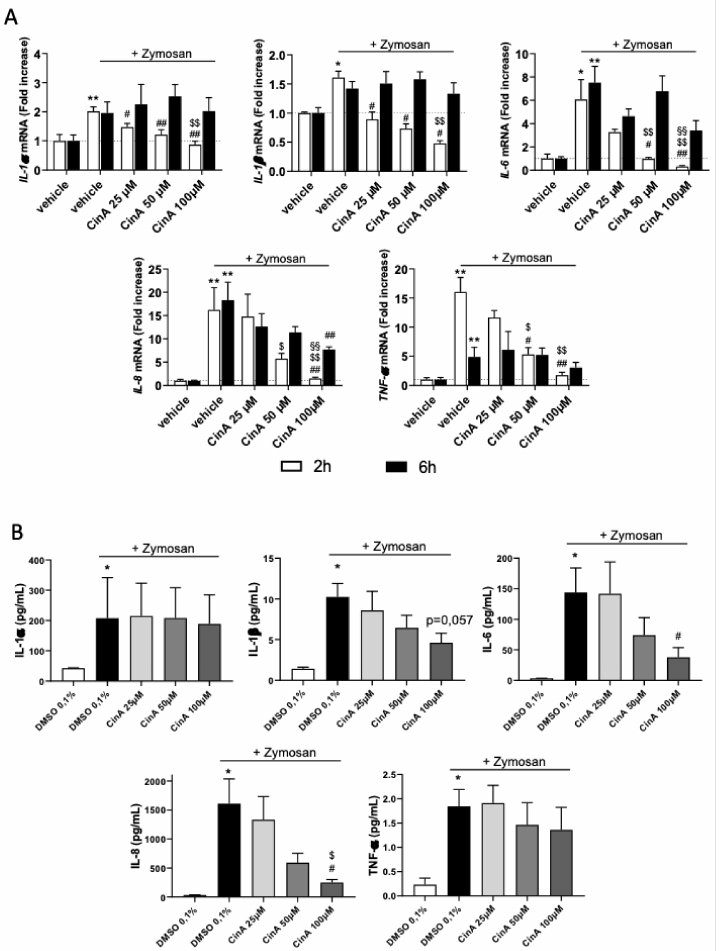
Figure 3. Low concentration of CinA controls zymosan-induced KC’s inflammatory response. KCs were exposed to different concentrations (25–100 µ M) of CinA at the same time of the zymosan A (20 µ g/mL) stimulation for 2, 6, and 24 h. ( A ) The mRNA level of inflammatory cytokines IL-1 α , IL- 1 β , IL-6, IL-8, and TNF- α determined by RT-qPCR after 2 and 6 h of exposure to zymosan ± CinA (25, 50, or 100 µ M) or DMSO 0.1% as the control. ( B ) Inflammatory cytokine levels determined by Meso Scaled Discovery technology in the supernatant of KERTr after 24 h of exposure to zymosan ± CinA (25, 50, or 100 µ M). Data represent the results of 4–6 independent experiments and are expressed as the mean ± SEM. ( A , B ) * Represents the statistical difference between zymosan and vehicle-treated cells, # represents the statistical difference between zymosan ± CinA and zymosan-treated cells, $ rep- resents the statistical difference between 50 or 100 µ M and 25 µ M of CinA and § represents statistical difference between 100 µ M and 50 µ M of CinA. *, #, $ p -value < 0.05 and **, ##, $$, §§ p -value <